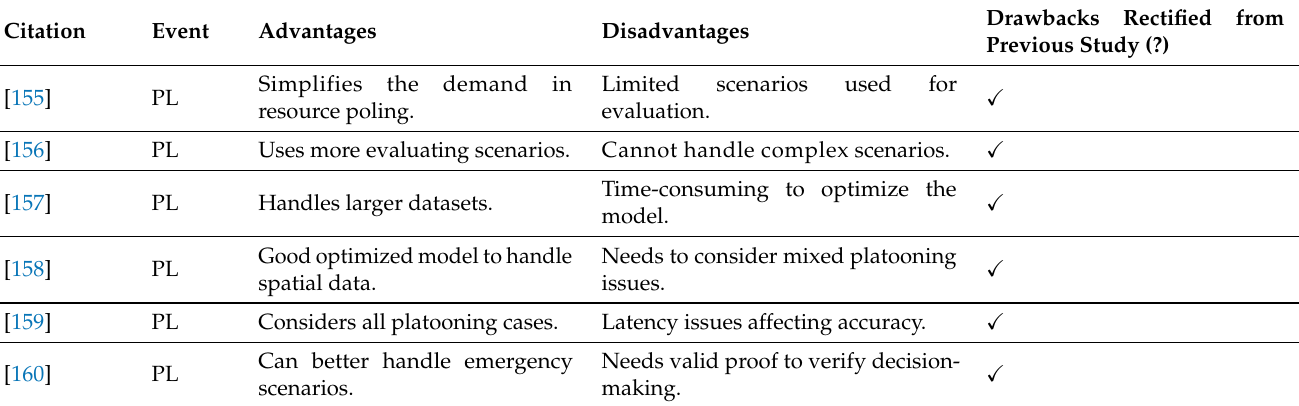
Table 9. Chronological summary of decision-making for platooning (PL) in